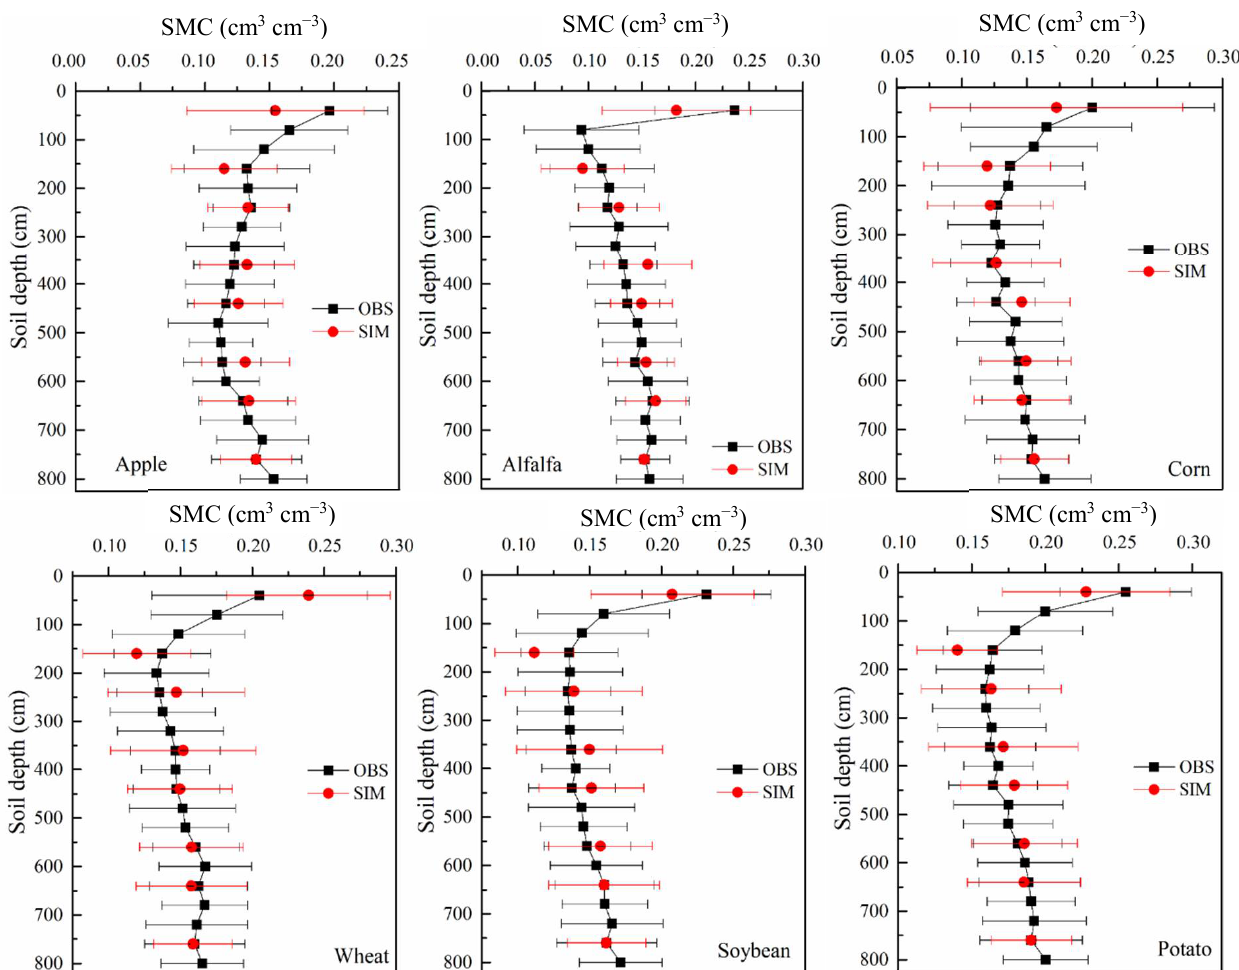
Figure 5. Comparison of observed (OBS) soil moisture content (SMC) and simulated (SIM) SMC in 0–800 cm soil layer. Error bars represent the standard deviation (SD).